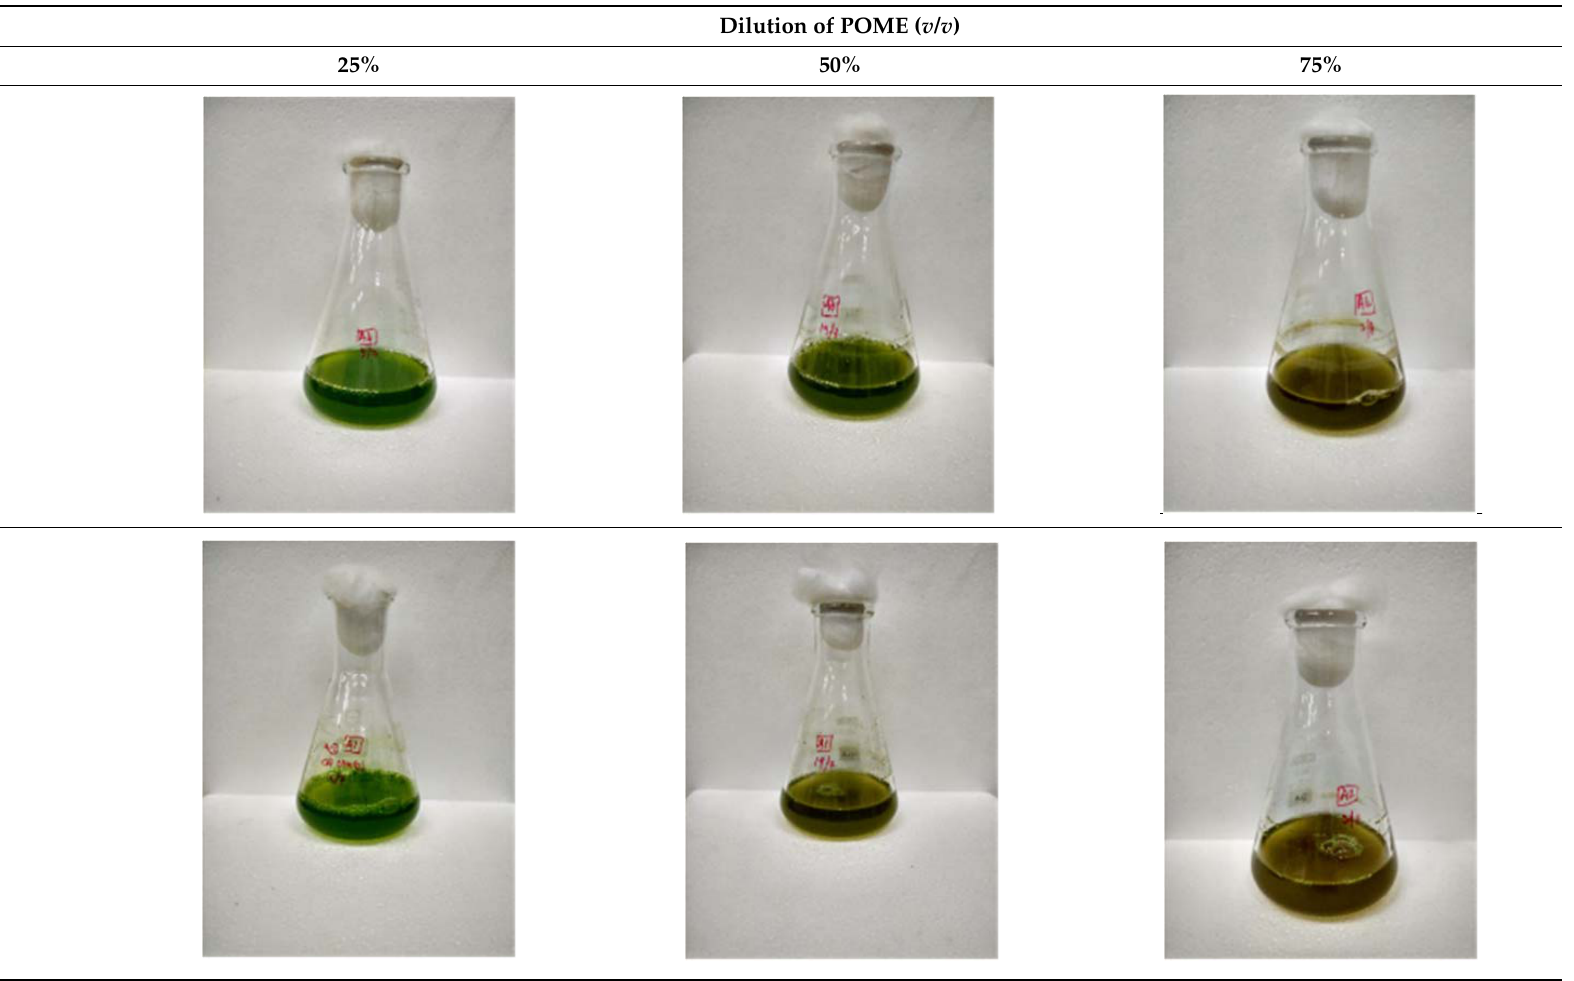
Table 3. Visible results of the three green microalgae cultivated in different dilutions (25%, 50%, and 75%; v / v ) of LABT-POME.